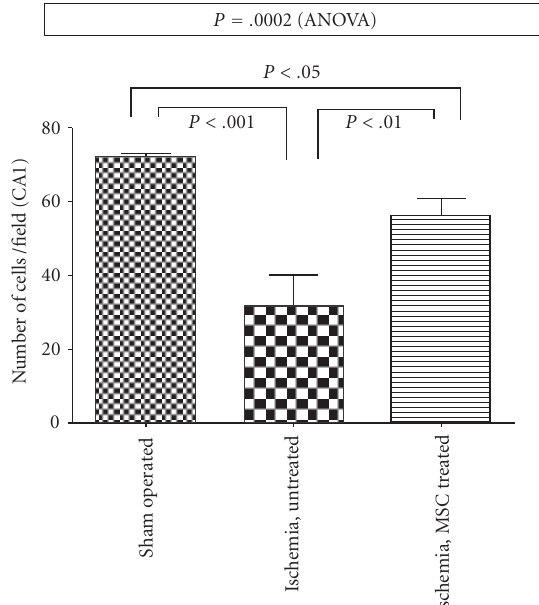
Figure 2: Number of vital neurons after ischemia in the various groups. Bars show mean and standard deviation. Probability values are for one-way analysis of variance (ANOVA) and for post hoc Bonferroni’s Multiple Comparison Test.